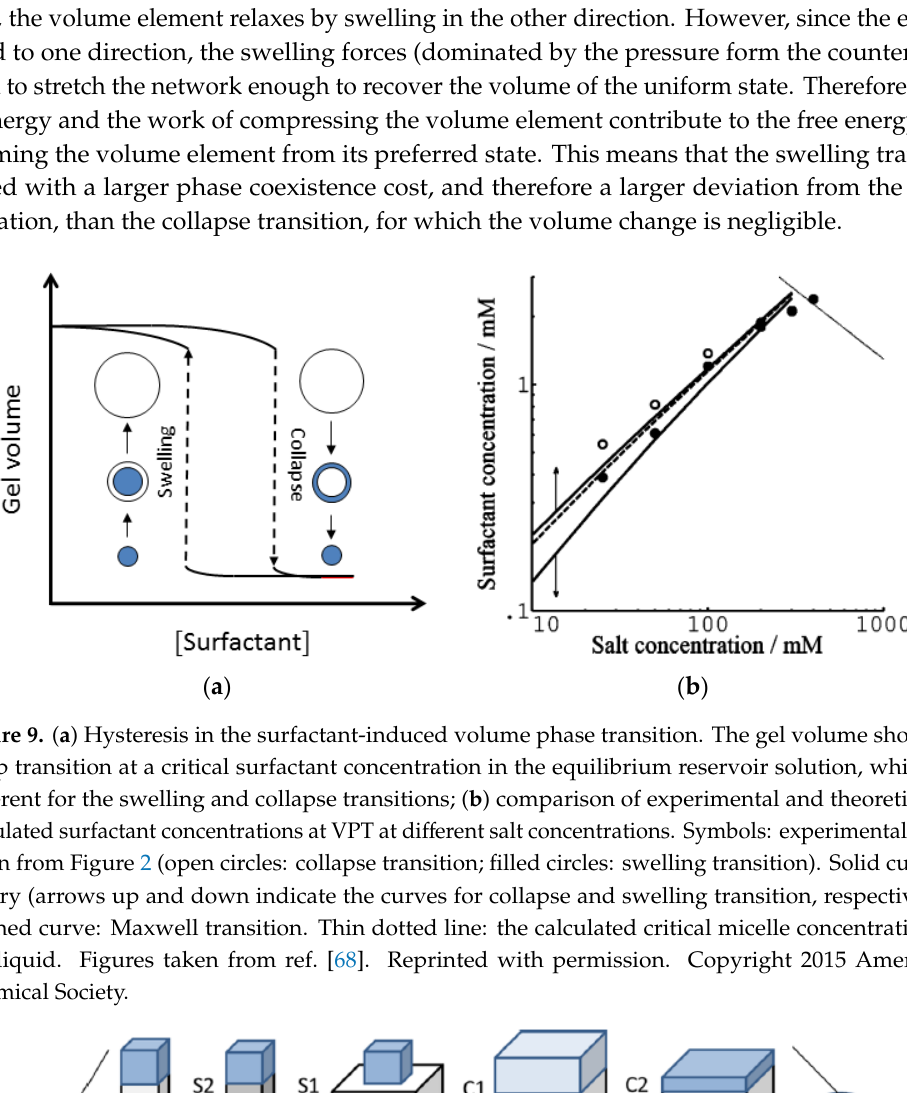
Figure 10. Deformation of shell. The requirement that the network strains in the directions parallel to the core − shell boundary be equal on both sides of the boundary leads to anisotropic deformation of the shell. Middle construct: collapsed (blue) and swollen (gray) volume elements in a hypothetical state without elastic coupling between core and shell. Constructs to the left (swelling transition): biaxial compression (S1) of the swollen shell element to impose the same lateral stretch as in the collapsed core, followed by relaxation (S2) to restore swelling equilibrium. Constructs to the right (collapse transition): biaxial stretch (C1) of the collapsed shell element to impose the same lateral stretch as in the swollen core, followed by relaxation (C2) to restore swelling equilibrium. Figure taken from ref. [68]. Reprinted with permission. Copyright 2015 American Chemical Society.